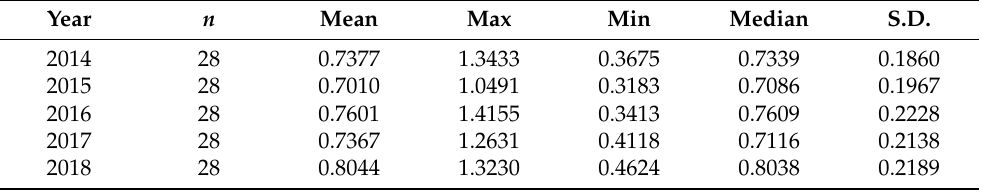
Table 4. Descriptive statistics on the importance of local governments on environmental protection.